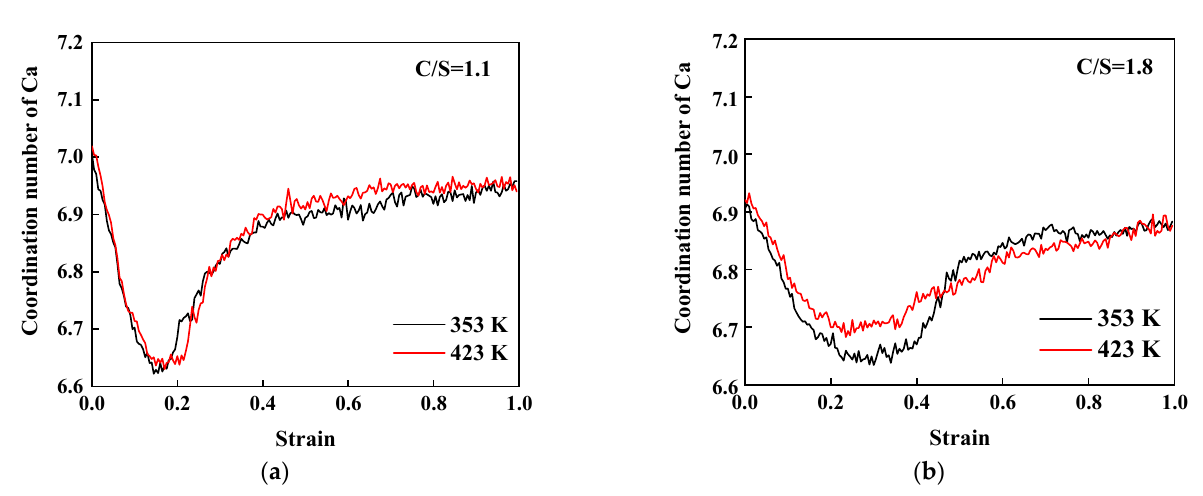
Figure 10. Mean chain length of silicate structure of C-S-H with different C/S ratios as a function of strain. ( a ) C/S = 1.1; ( b ) C/S = 1.8.